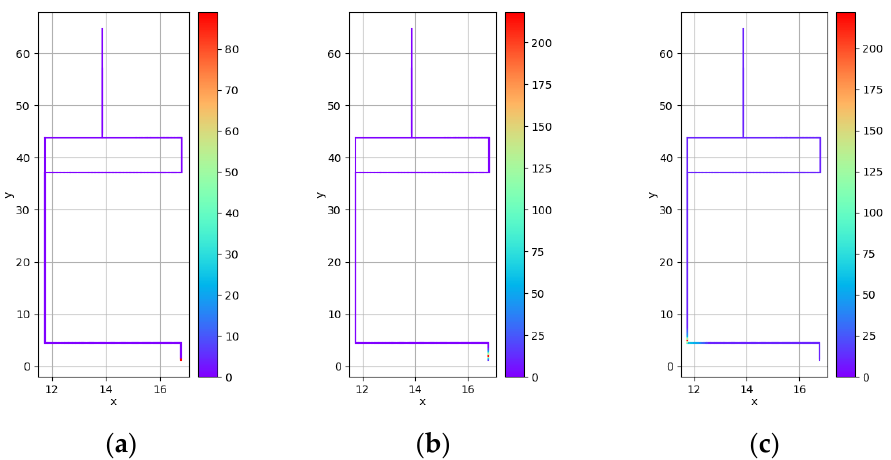
Figure 9. Indoor virus quanta concentrations at 0 s ( a ), 0.5 s ( b ), and 5 s ( c ), respectively, from the start of the movement.